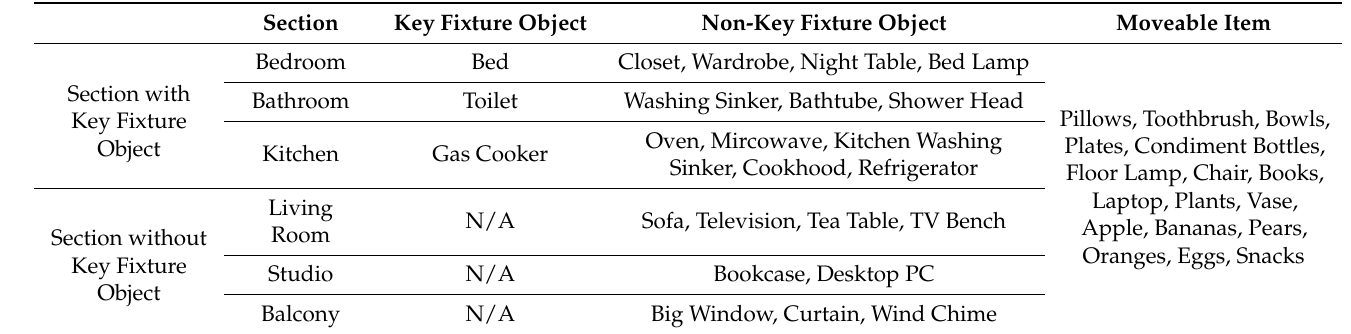
Table 1. Groups of space types and with association of key